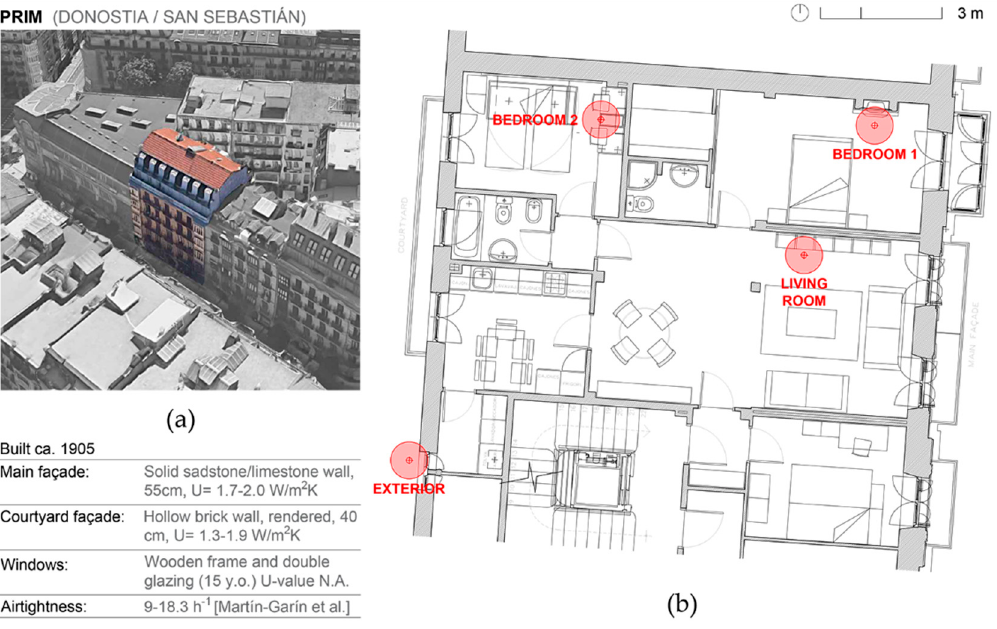
Figure 3. ( a ) Aerial perspective of the Prim building. Source: Google Maps. ( b ) Floorplan of the monitored flat, with indication of the dataloggers’ locations. Source: authors. monitored flat, with indication of the dataloggers’ locations. Source: